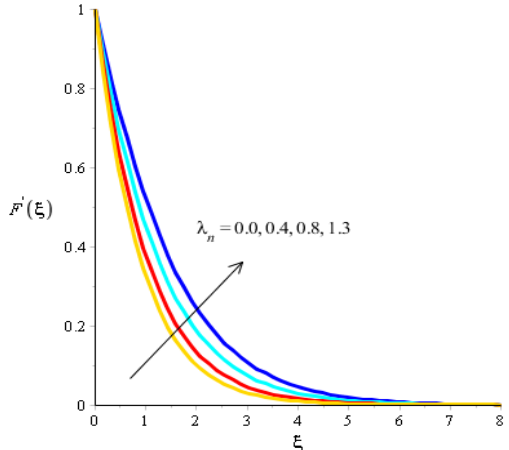
Figure 5. Analysis of velocity curves versus 𝜆 (cid:3041) .